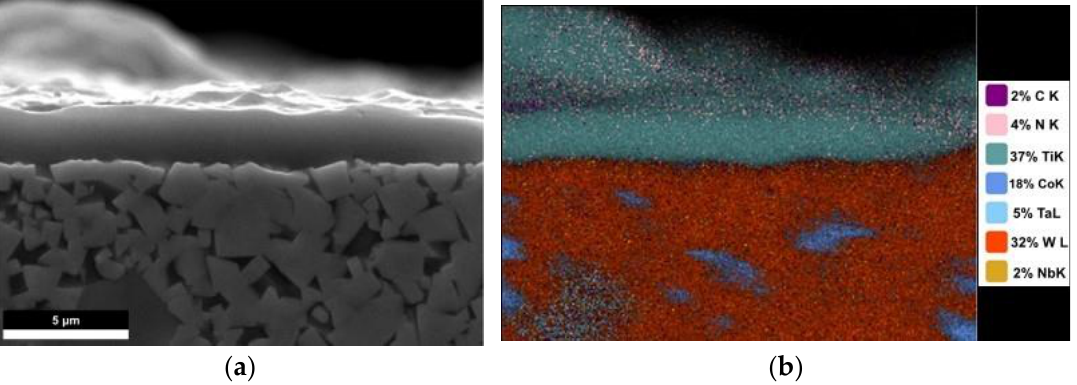
Figure 1. The SEM images of: ( a ) TiN – substrate interface; ( b ) TiN – substrate element overlay.